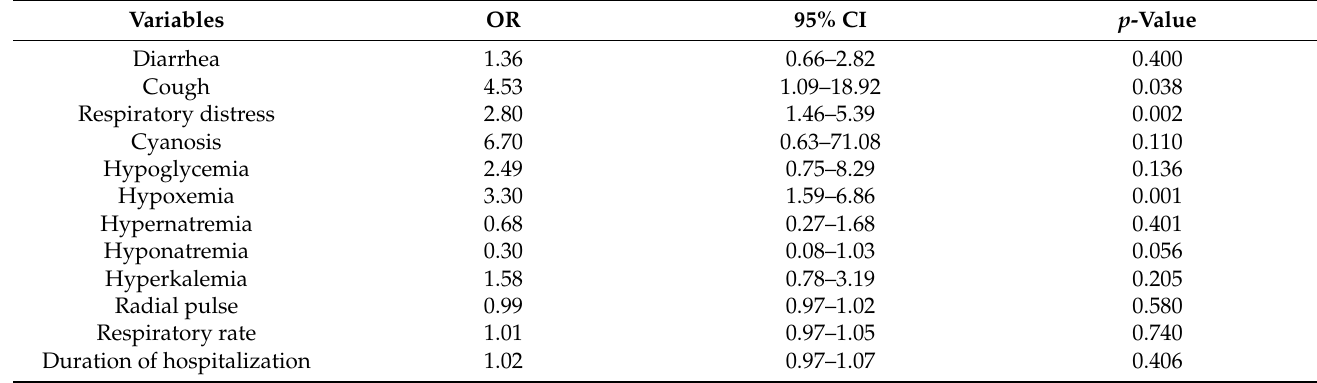
Table 3. Regression model to explore the independent association in children with